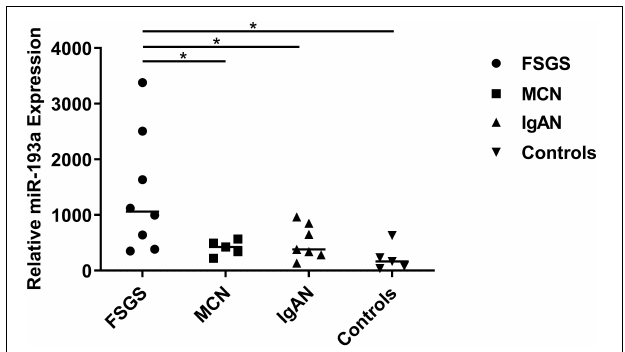
FIGURE 2 | Relative expression levels of urine exosomal miR-193a between patients with FSGS patients and controls. Relative expressions were shown which was calculated with the equation 2 − delta Ct , normalized for RNU6 and relative to the control average. Scatter plot (middle line: median). * P < 0.05.